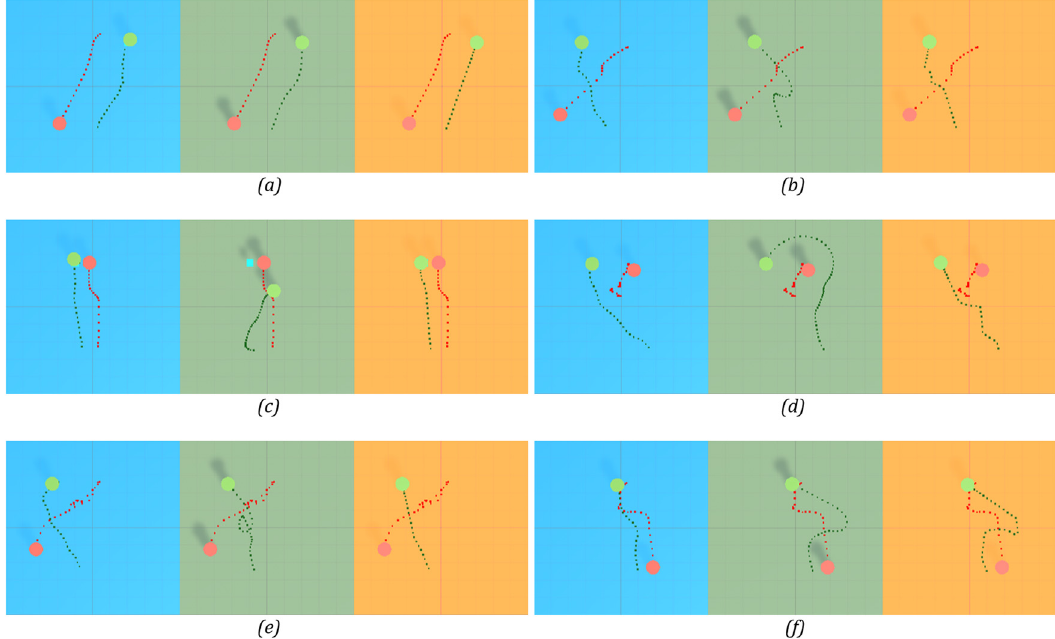
Figure 10: Example interacting situations between agent and obstacle in comparison with Social Force Model and Unity NavMesh. The green circle represents the agent and the red circle represents the obstacle. ( a ) The agent and the obstacle move in two opposite directions; ( b ) The obstacle crosses path with the agent; ( c ) The obstacle obstructs the agent's path to the destination; ( d ) The obstacle moves slowly around the agent; ( e ) The obstacle moves slowly intersecting the agent's path; ( f ) The obstacle unexpectedly changes its